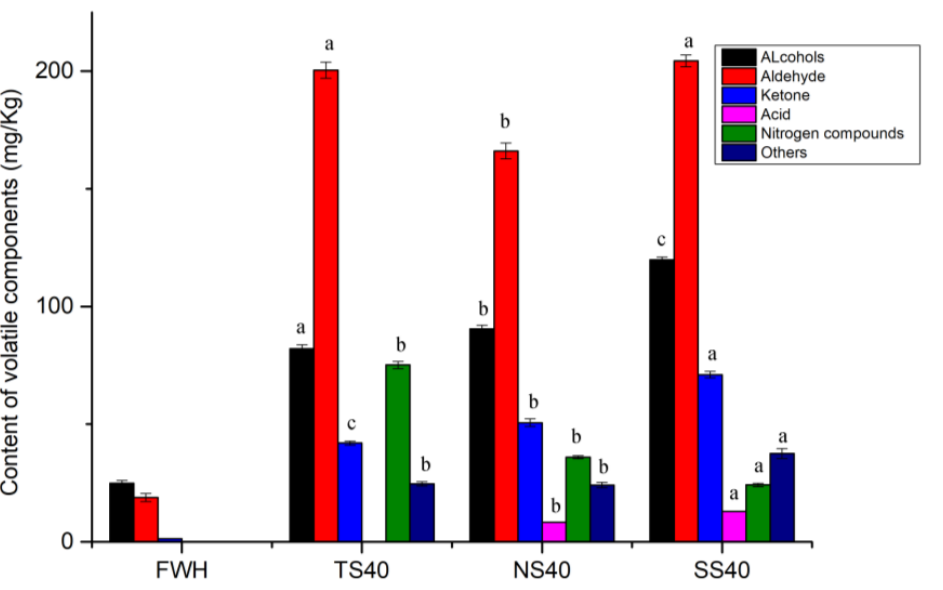
Figure 3. The content of volatile components in the salted herrings processed under different conditions. Lowercase letters (a, b, c) indicate significant differences for evisceration with inoculum for p < 0.05.